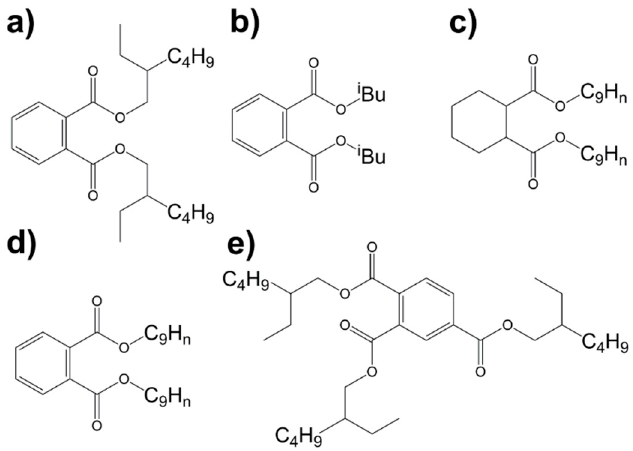
Figure 1. Structure of the investigated plasticizers in the current study: ( a ) diethylhexyl phthalate (DEHP), ( b ) diisobutyl phthalate (DIBP), ( c ) diisononyl cyclohexane-1,2-dicarboxylate (DINCH), ( d ) diisononyl phthalate (DINP), ( e ) tris(2-ethylhexyl) trimellitate (TOTM).